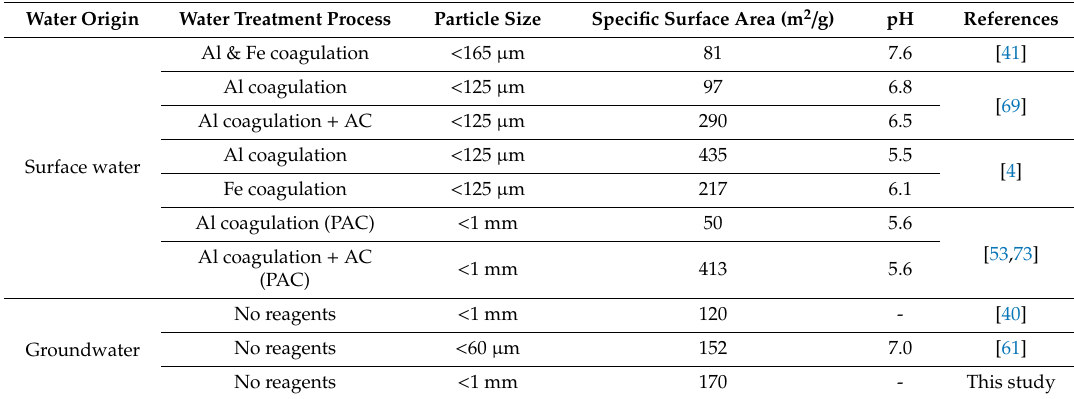
Table 3. Comparison of some physical properties of WTRs (water treatment